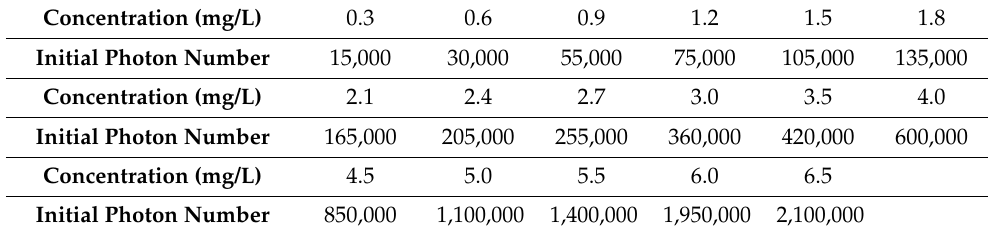
pended matter concentrations.